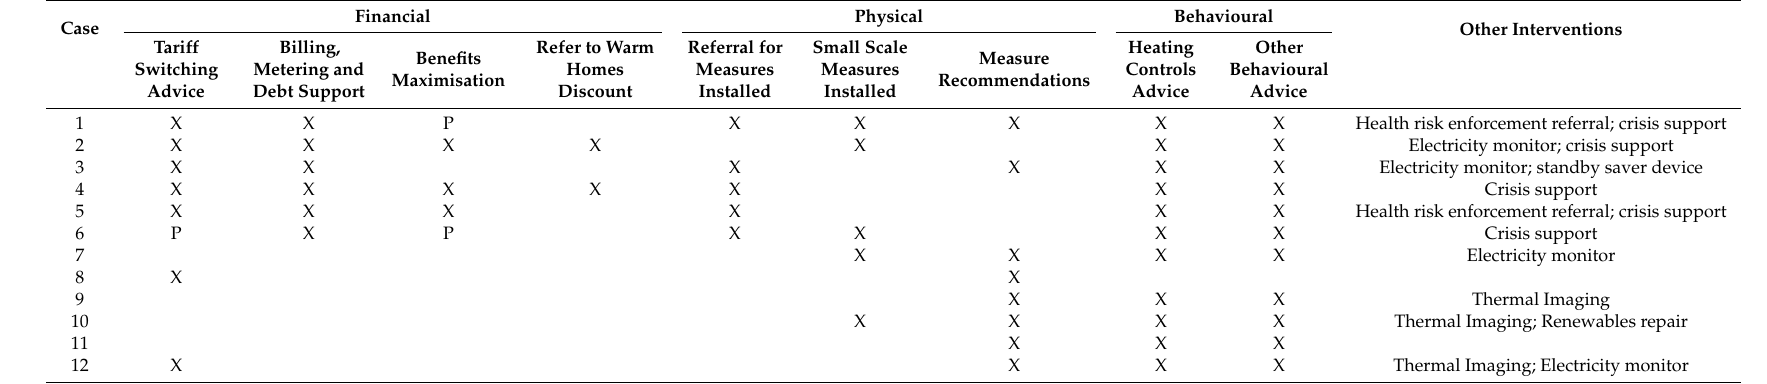
Table 1. Interventions carried out by each